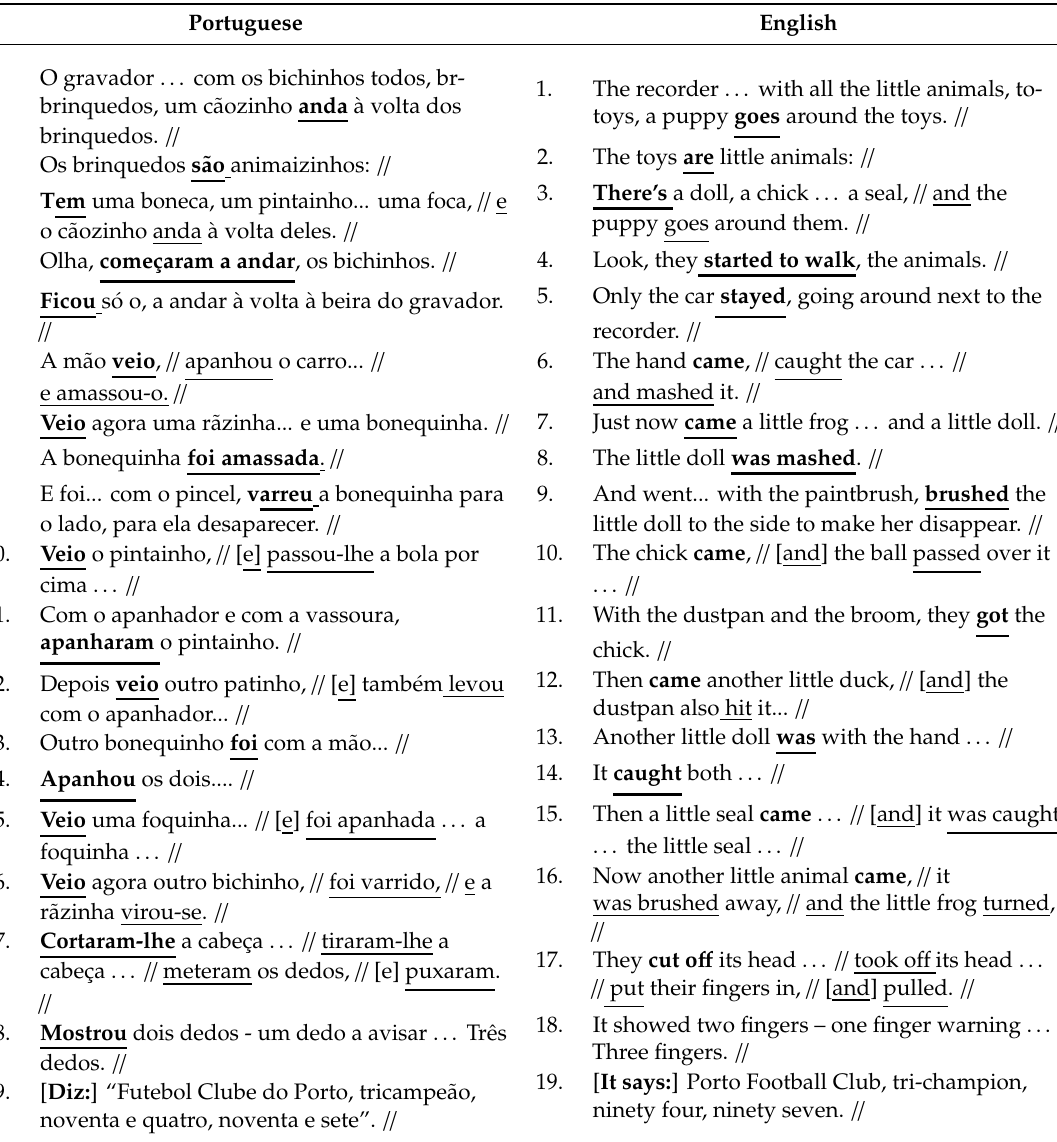
Table A1. Stimulus